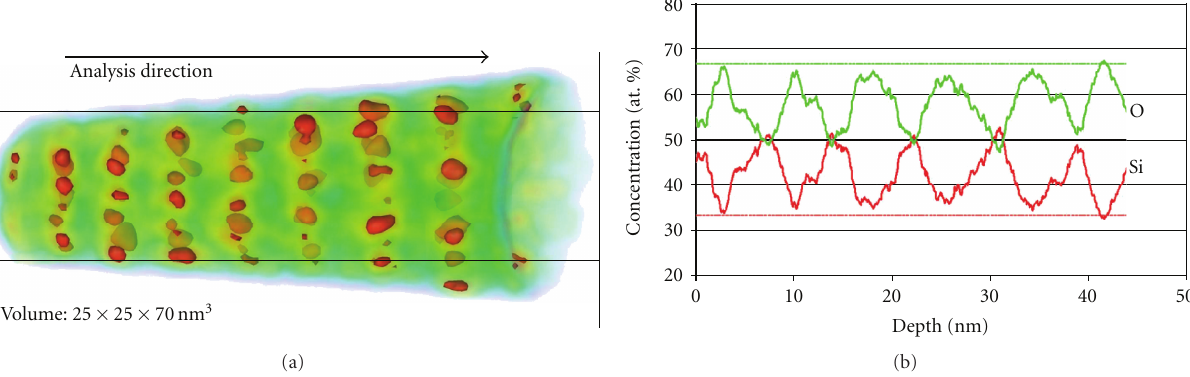
Figure 8: (a) 3D reconstruction of APT analysis on Si-nc-SiO 2 /SiO 2 multilayers. (b) Composition profile along the growth direction.